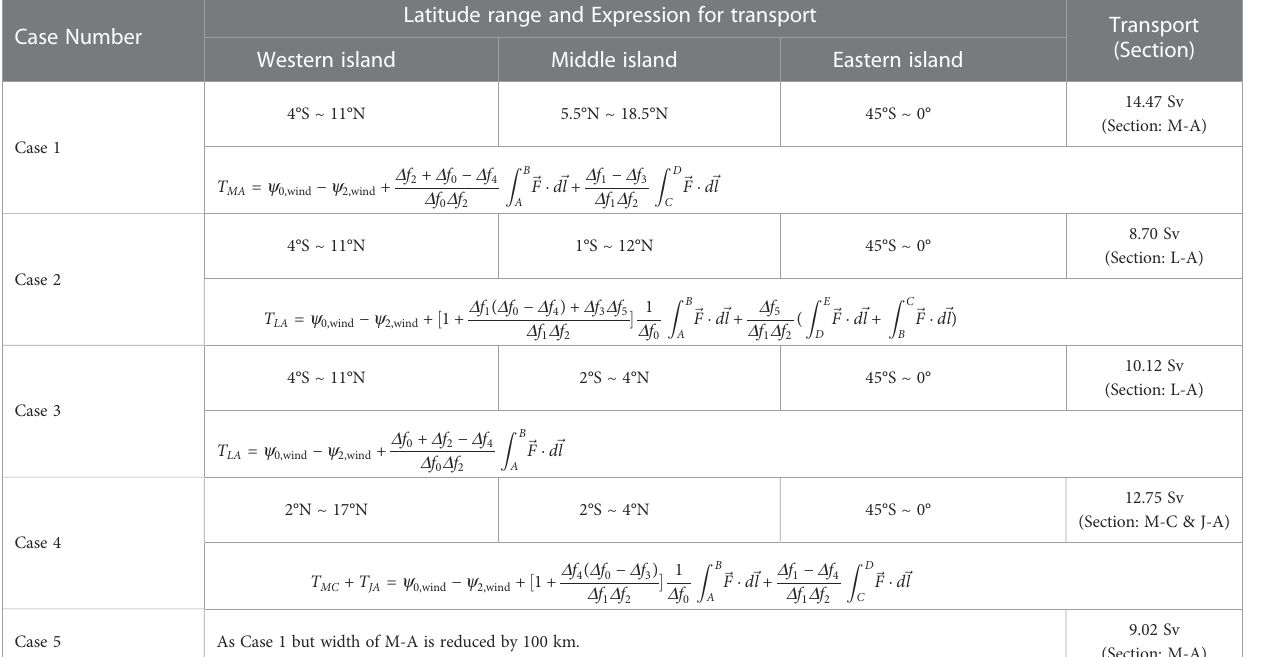
TABLE 1 Islands setup and corresponding channel transports in the fi ve cases.